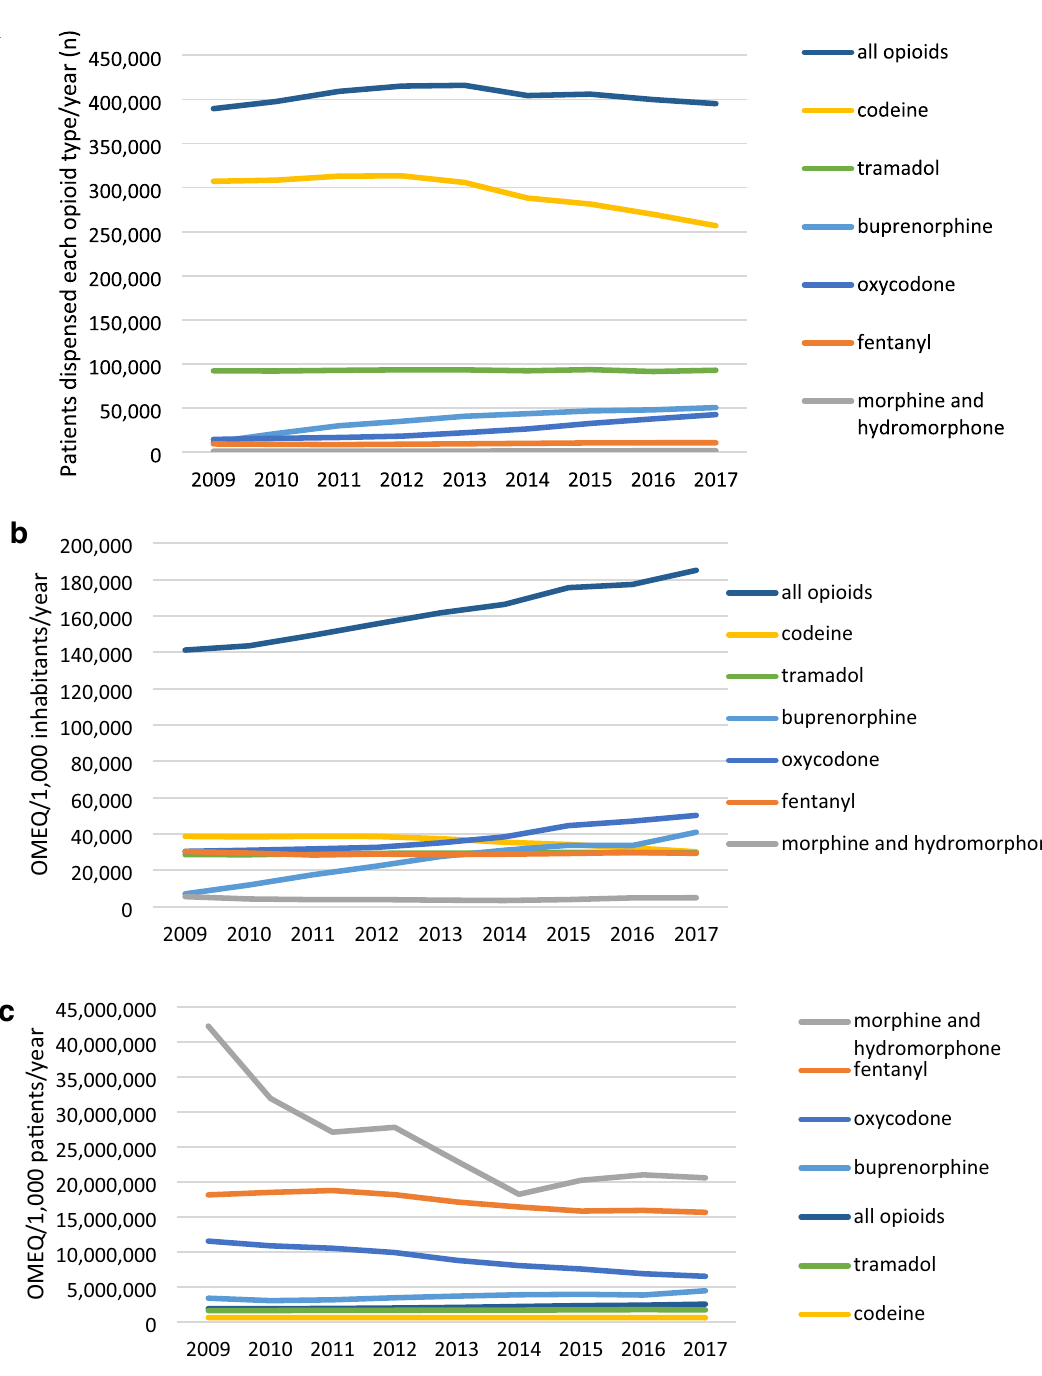
Figure 2. ( a) Number of patients with a dispensed opioid prescription during the calendar year, reported by opioid ATC class. ( b ) Opioid use in oral morphine equivalent mg (OMEQ) per 1,000 inhabitants in Finland, reported by opioid ATC class. ( c ) Mean intensity of opioid use per 1,000 opioid patients by opioid class in Finland. Intensity is expressed in oral morphine equivalent mg (OMEQ) for 1,000 patients who used each opioid class during the calendar